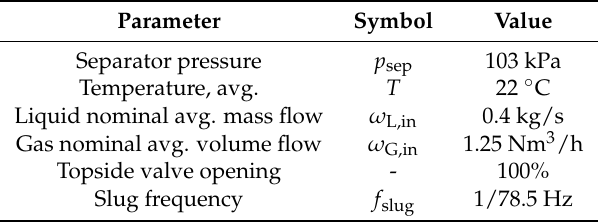
Table 2. Experimental test results. Volumes are stated for normal